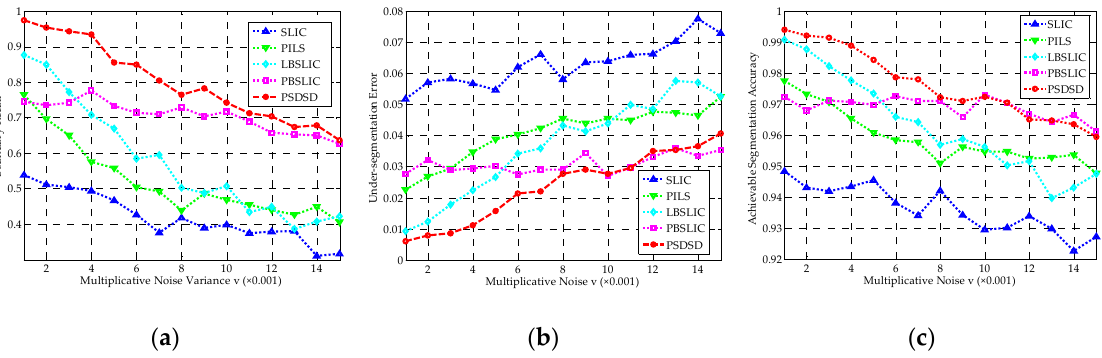
Figure 13. The BR, USE, and ASA results for SLIC, PILS, LBSLIC, PBSLIC, and PSDSD, with m set to 8, K set to 0.0075, and v set to from 0.001 to 0.015. ( a ) BR; ( b ) USE; ( c ) ASA. From the results in Figure 14, we can see that all of these methods obtain favorable superpixel results when the noise variance is small. However, when speckles become stronger and stronger, the performances of SLIC, PILS, and LBSLIC become dramatically worse. Our method shows much better results than other methods when the speckle is relatively weaker, and in stronger noise situations, our method yields more regular results than PBSLIC.